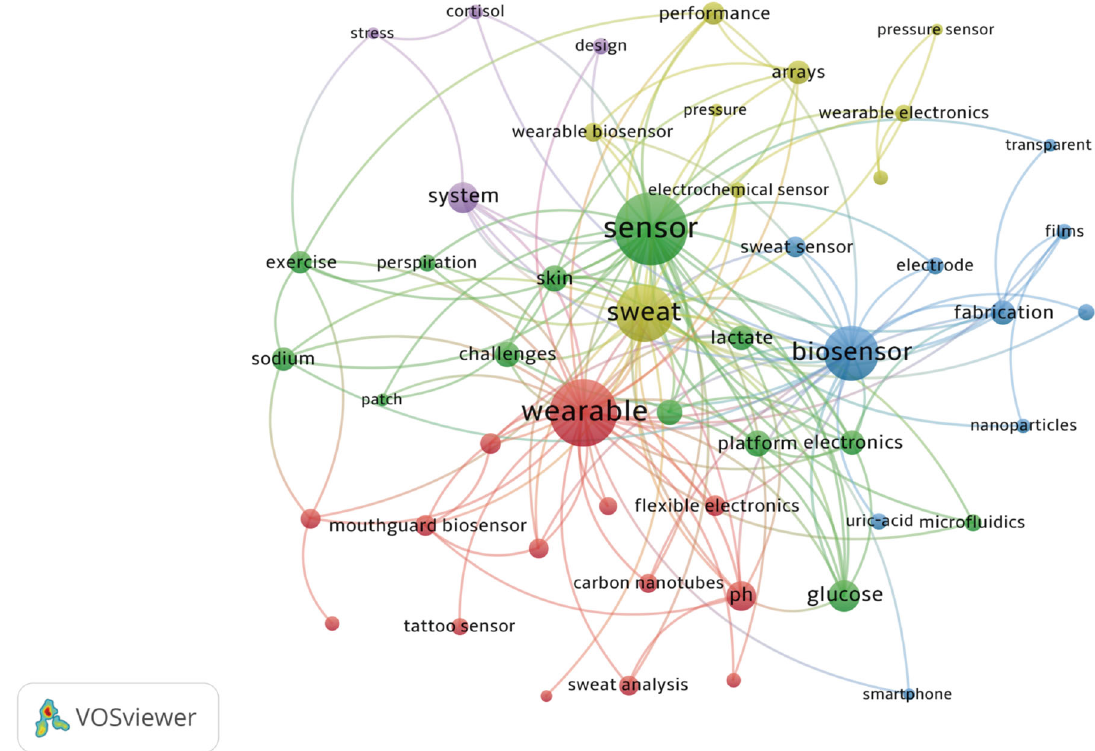
Fig. 1 Network visualization map of the top 50 keywords in documents returned from a search on wearable sweat sensors. The map was created by